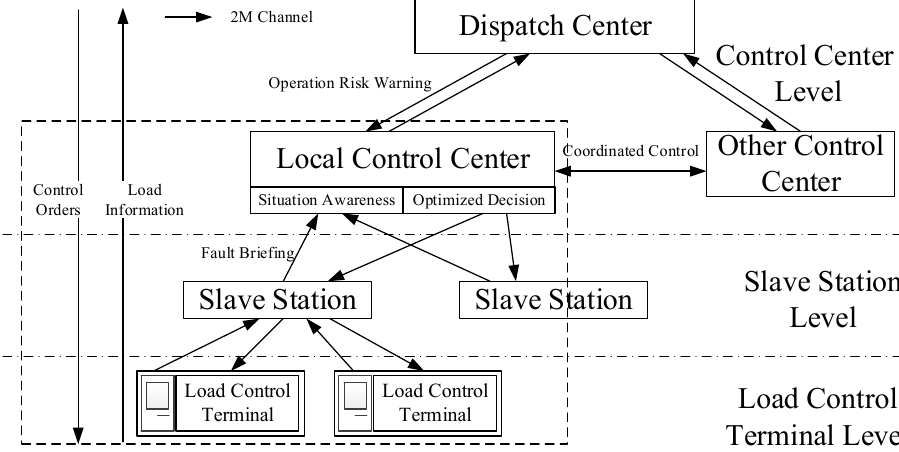
Figure 2. Control structure of the active power load participating in the frequency emergency control.